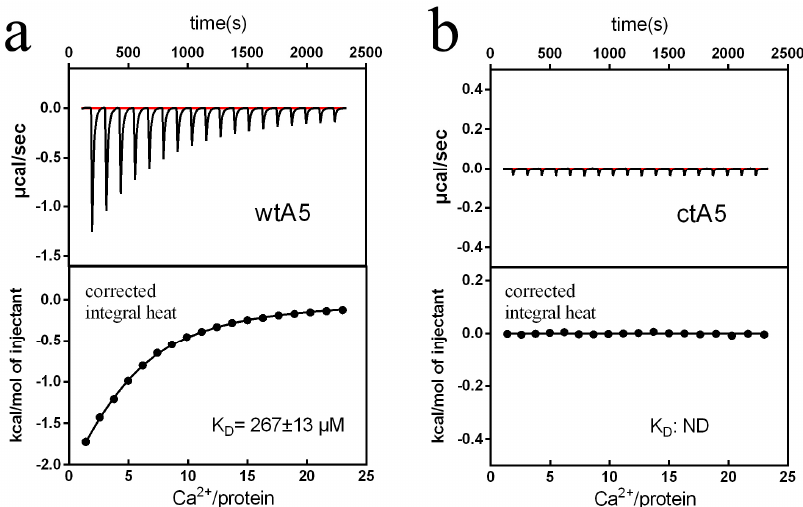
Figure 4. Titration of wtA5 and ctA5 with calcium. ( a ) Titration of 60 μ M wtA5 with 7 mM calcium. ( b ) Titration of 60 μ M ctA5 with 7 mM calcium. For each profile, the top shows the raw ITC data output during titration. The bottom represents the experimental points and the best fit. The points are derived from the raw data, and the heat of dilution was subtracted using the blank control of buffer titrated with calcium. The solid line at the bottom of each profile represents the best fit. n = 2. Table 1. Parametric analysis of calcium titration.